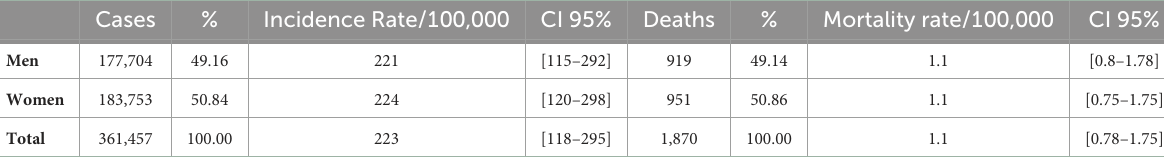
TABLE 3 Number of WaSH related cases and deaths in Ecuador from 2011 to 2020.